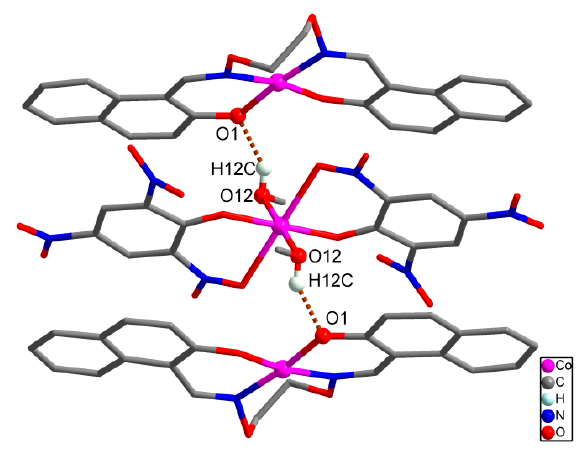
Table 4. The main hydrogen bonds [Å,°] for complex 1 .